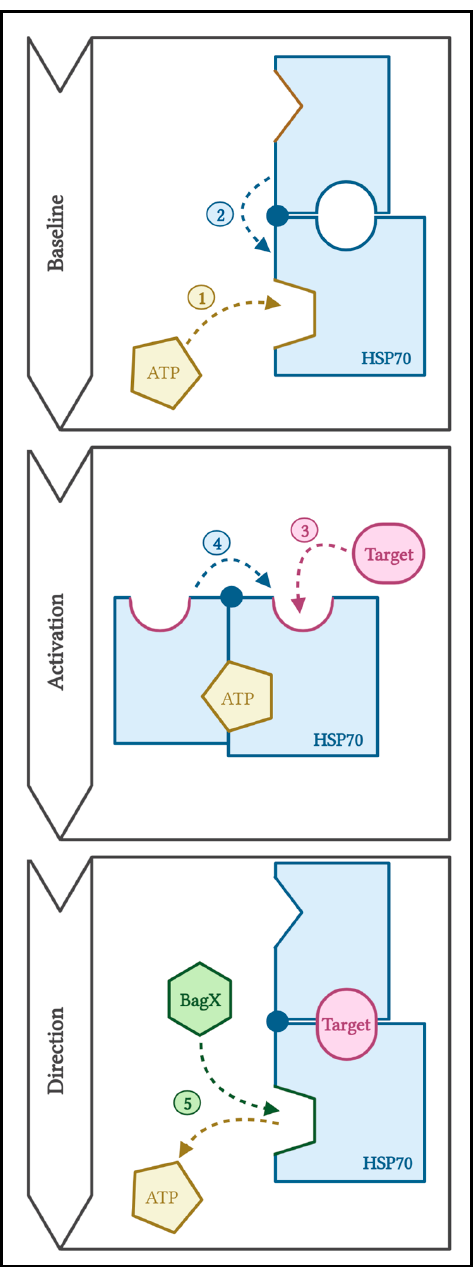
Figure 2. Mechanism of function of HSP70. (1) ATP binds ATPase. (2) A conformational change in the hinged cap inhibits the ATPase and exposes the SBD. (3) An aberrant protein binds SBD. (4) A conformational change traps the substrate. (5) Directional proteins compete for the ATPase binding site.